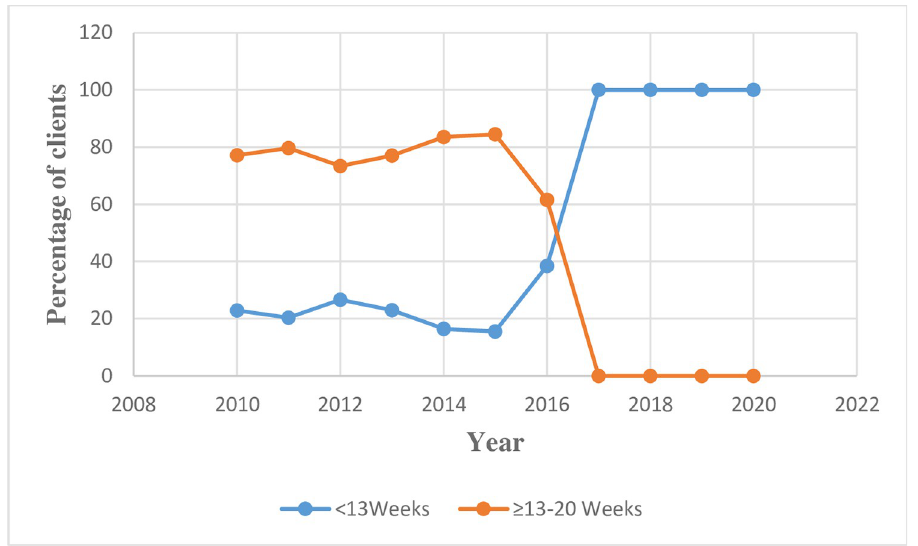
Fig 2. Trends in the annual proportion of clients for Abortion procedures stratified by proportion gestational age at presentation.